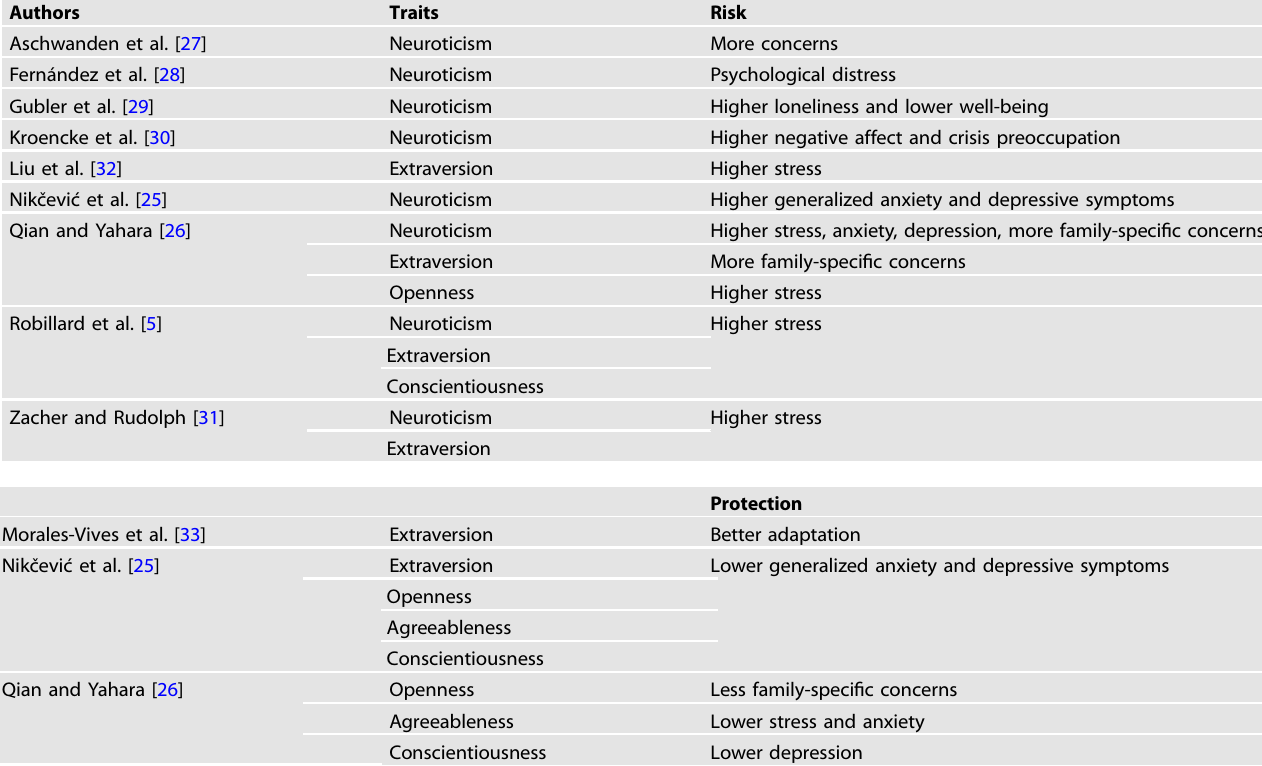
Table 1. Current studies on associations of the Big Five personality traits with psychological adjustment and stress since outbreak of the Covid-19